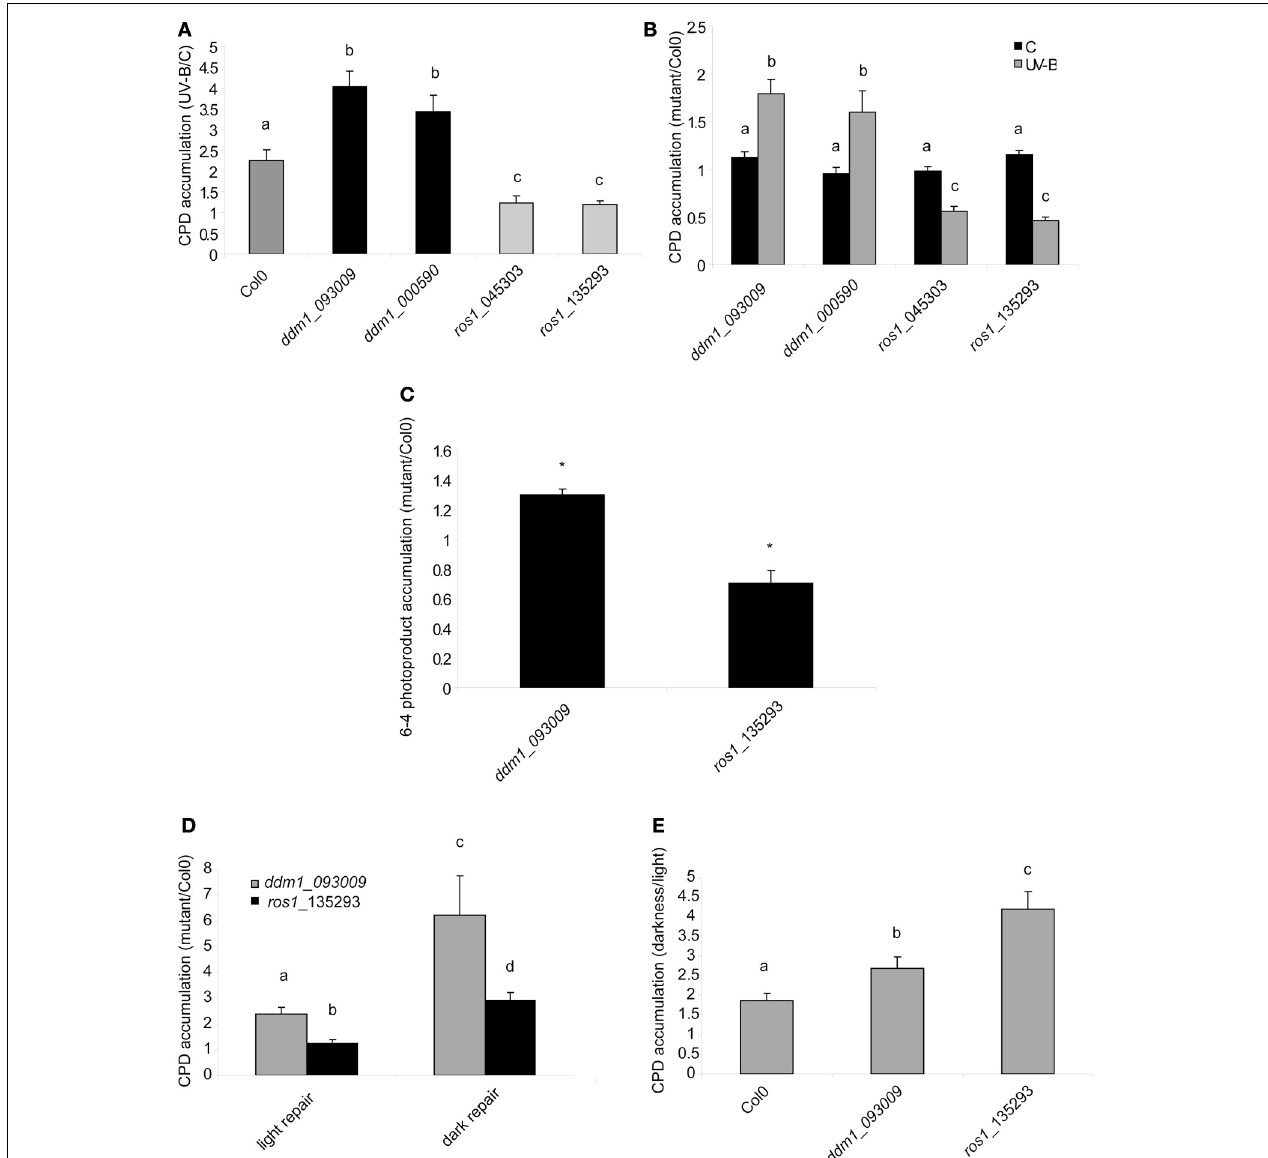
FIGURE 3 | CPD and 6-4PPs levels in the DNA of Col0, ddm1 and ros1 arabidopsis plants. (A) CPD levels in DNA of UV-B treated Col0, ddm1, and ros1 plants for 4h, relative to levels under control conditions without UV-B (C). (B) CPD levels in DNA of ddm1 and ros1 plants relative to Col0 plants under control conditions without UV-B (C) and after a 4h-UV-B treatment (UV-B). (C) 6-4PPs levels in DNA of ddm1 and ros1 plants relative to Col0 plants after a 4h-UV-B treatment. (D) CPD levels in DNA of ddm1 and ros1 plants relative to Col0 plants after a recovery period in the absence of UV-B